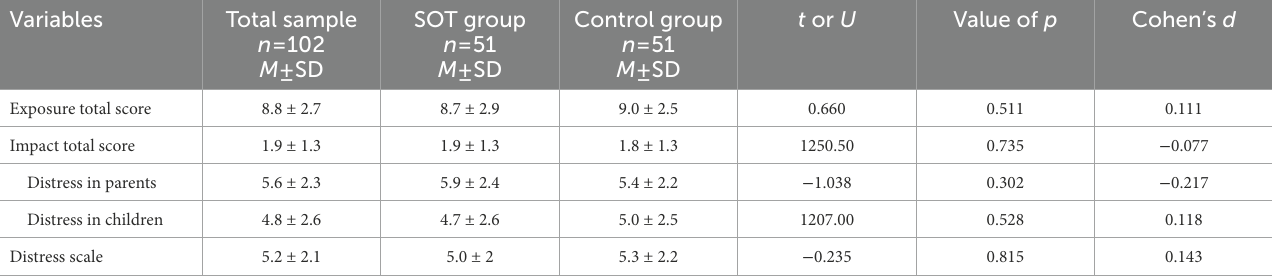
TABLE 5 COVID-19 exposure and family impact survey